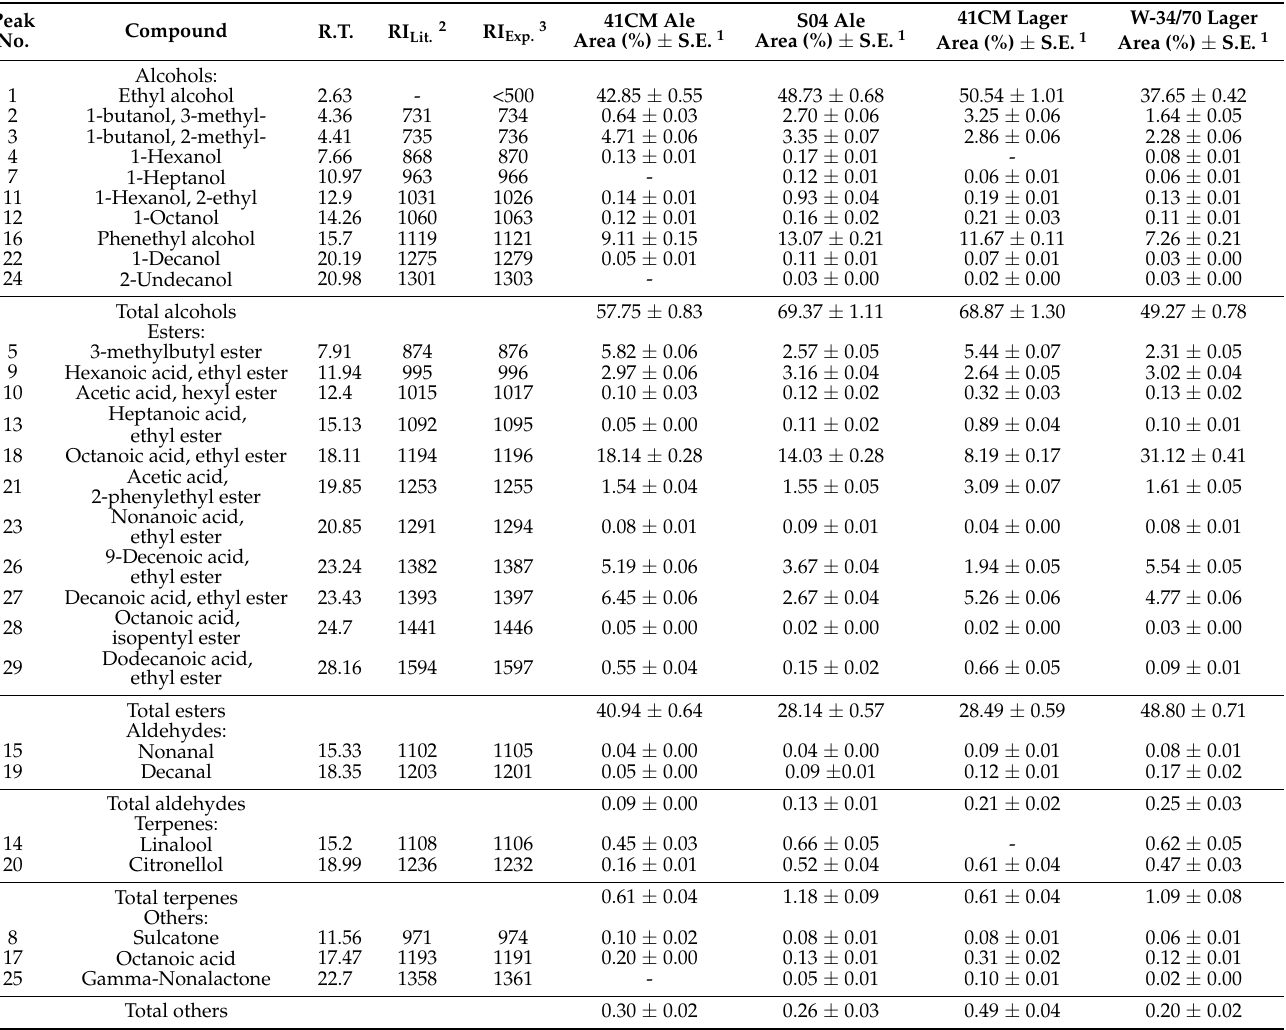
Table 3. Main volatile compounds identified (expressed as percentage of the peak area of each compound compared to the total area) in the ale and lager beers produced by different